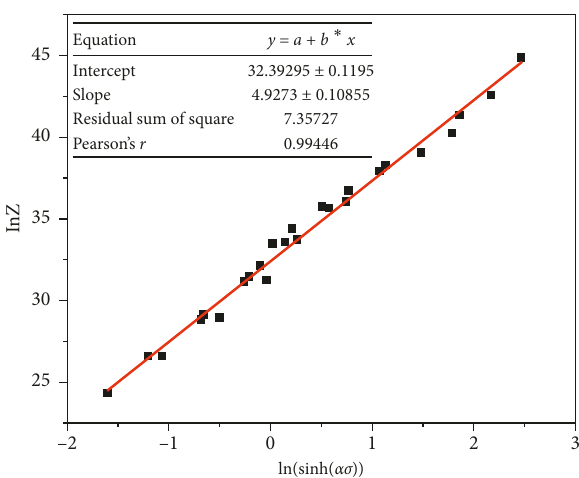
Figure 4: Relationships between ln Z and ln ( sinh ( ασ ))